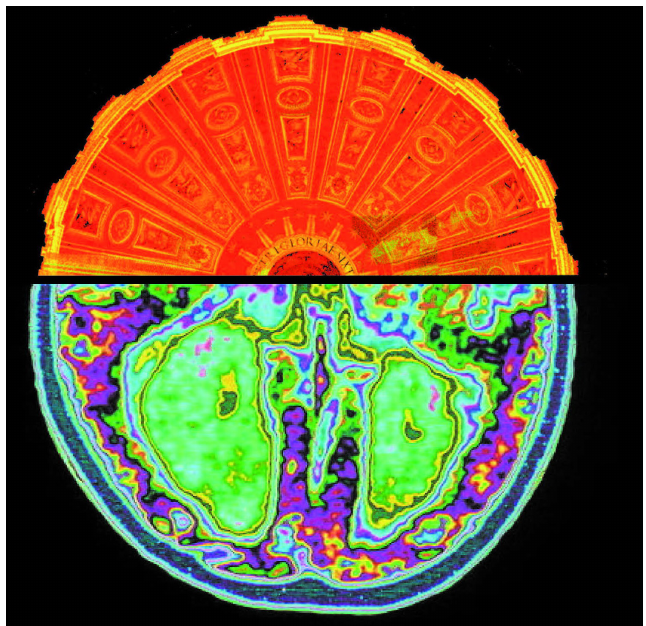
Fig. 1 Anatomographics: St Peter’s Dome point cloud (above) and functional RNM